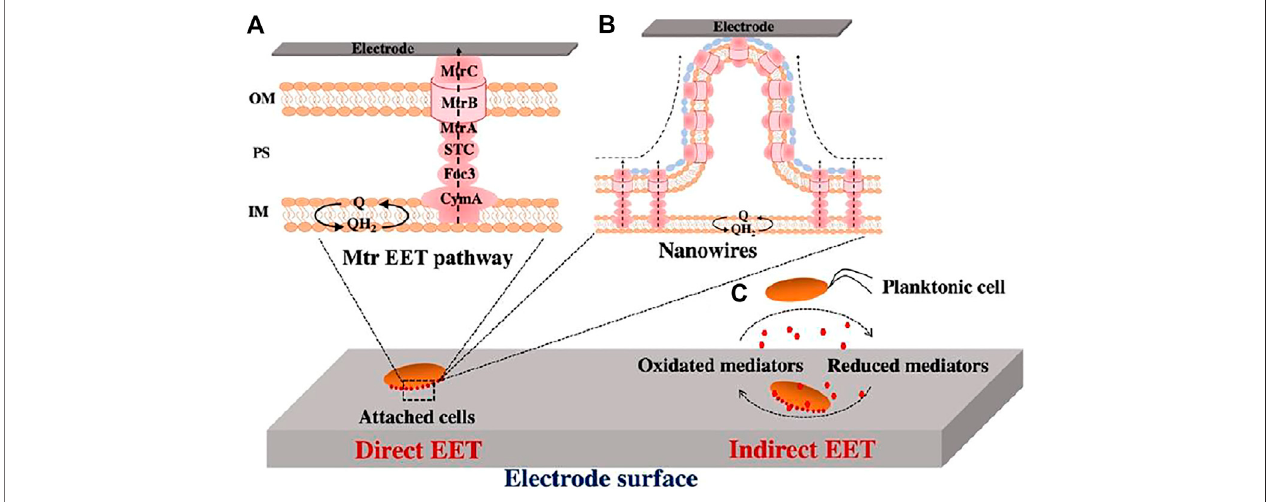
FIGURE 1 | Extracellular electron transfer (EET) pathways of Shewanella oneidensis MR-1 to electrodes. (A) Direct electron transfer via Mtr pathway. (B) Direct electron transfer via the outer membrane and periplasm extensions (previously described as nanowires). (C) Indirect electron transfer via electron shuttle fl avins. Q, quinone, QH 2 , quinol, IM, inner membrane, PS, periplasmic space, OM, outer